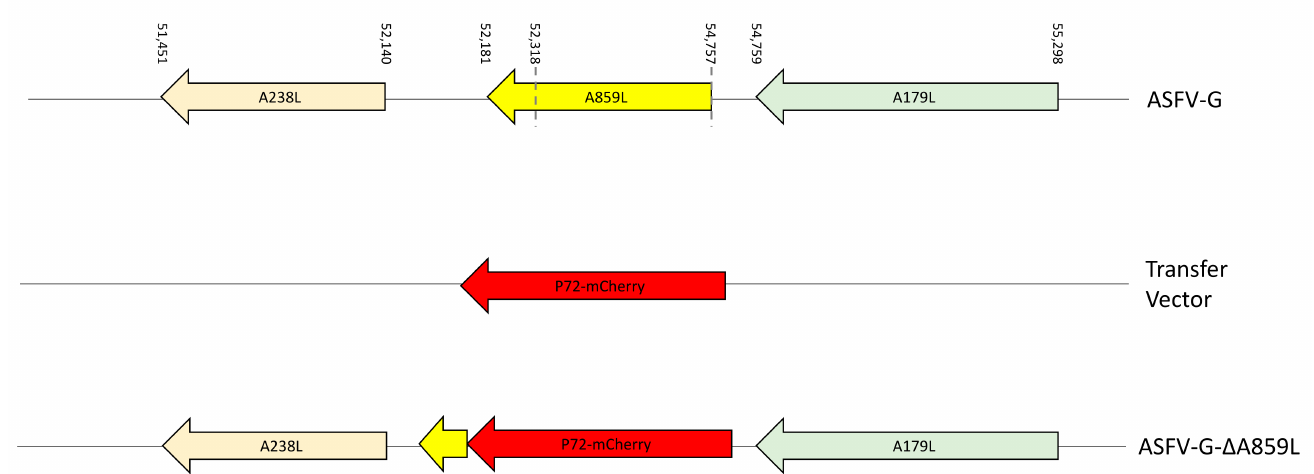
Figure 2. Schematic for the development of ASFV-G- ∆ A859L. The transfer vector contains the p72 promoter and a mCherry cassette; the gene positions are indicated. The homologous arms were designed to have flanking ends to both sides of the deletion/insertion cassette. The nucleotide positions of the area that was deleted in the ASFV-G genome are indicated by the dashed lines. The resulting ASFV-G- ∆ A859L virus with the cassette inserted is shown on the